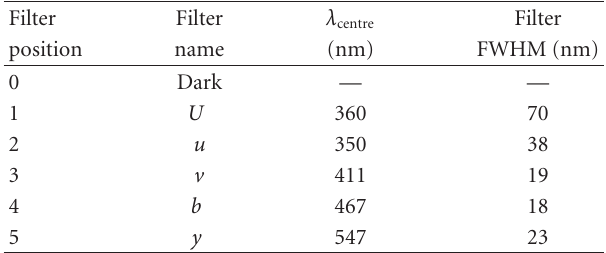
Table 1: FRAM filter